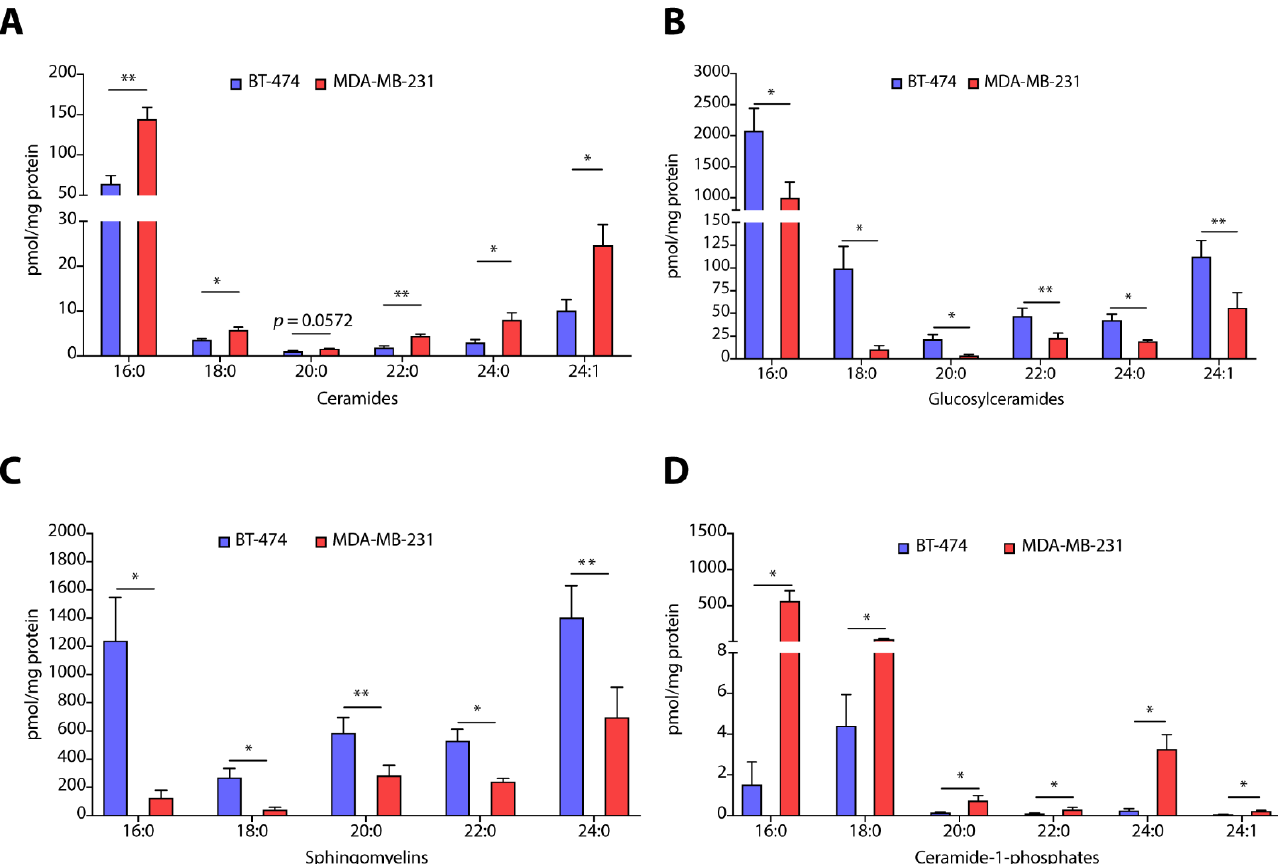
Figure 2. ( A – D ) Absolute quantification of different sphingolipids such as ceramides ( A ), glucosylceramides ( B ), sphingomyelins ( C ), and ceramide-1-phosphates ( D ) in TPBC representing BT-474 and TNBC representing MDA-MB-231 cells. Data are presented as mean ± SEM of six independent replicates, and were analyzed by unpaired student’s t -test. p value: * p < 0.05, ** p < 0.01.